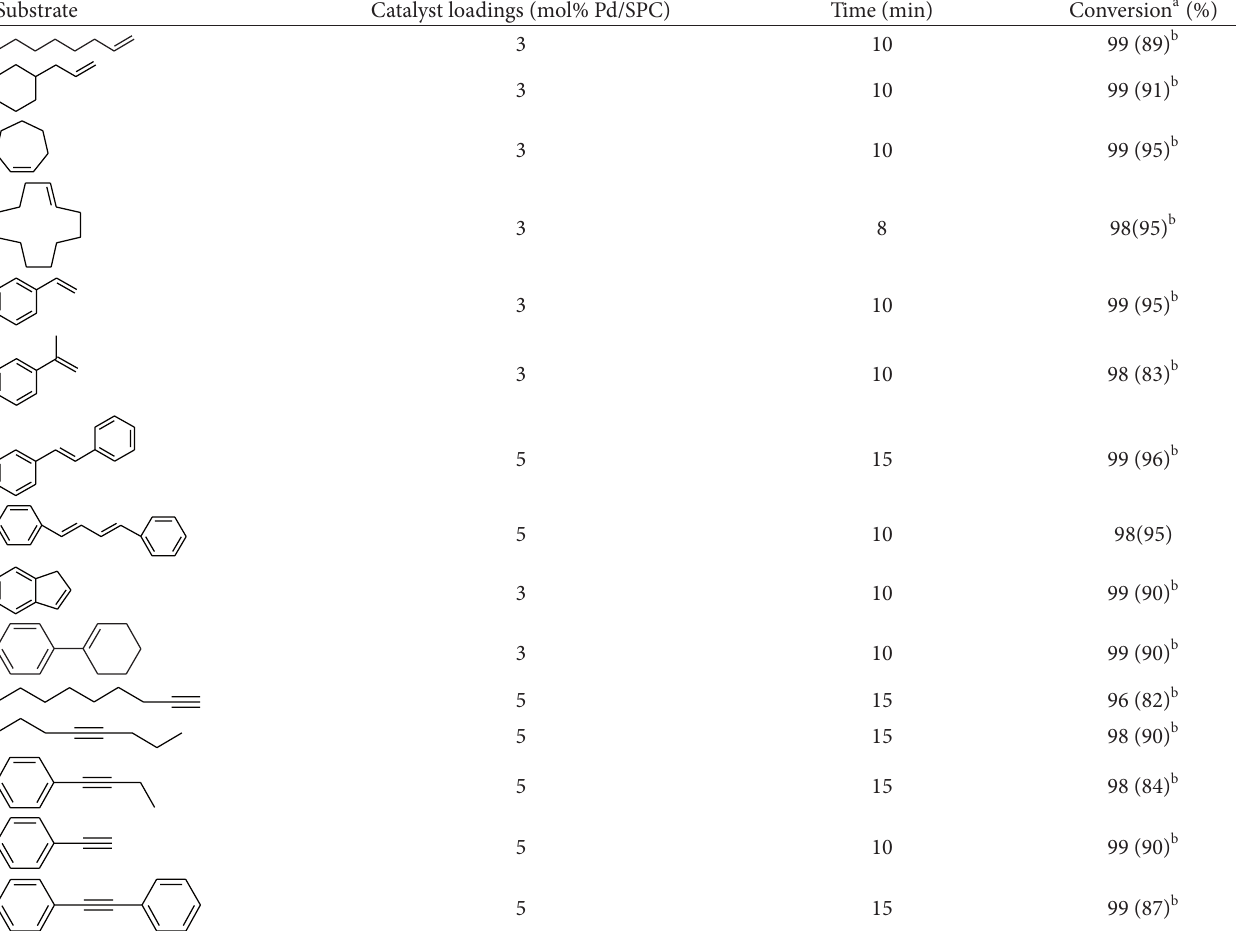
T 2: Reduction of alkynes and alkenes to the corresponding alkanes at room temperature.